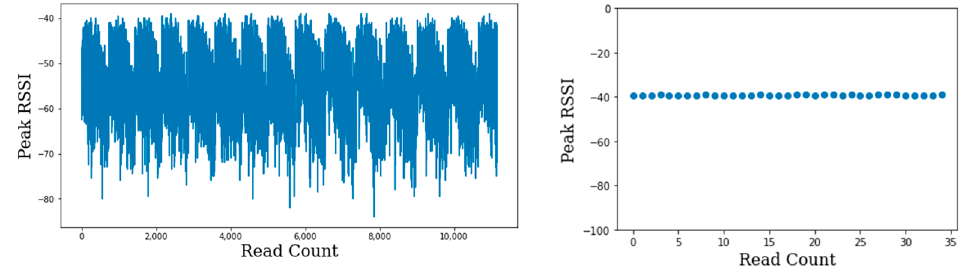
Figure 4. Card filter implementation.